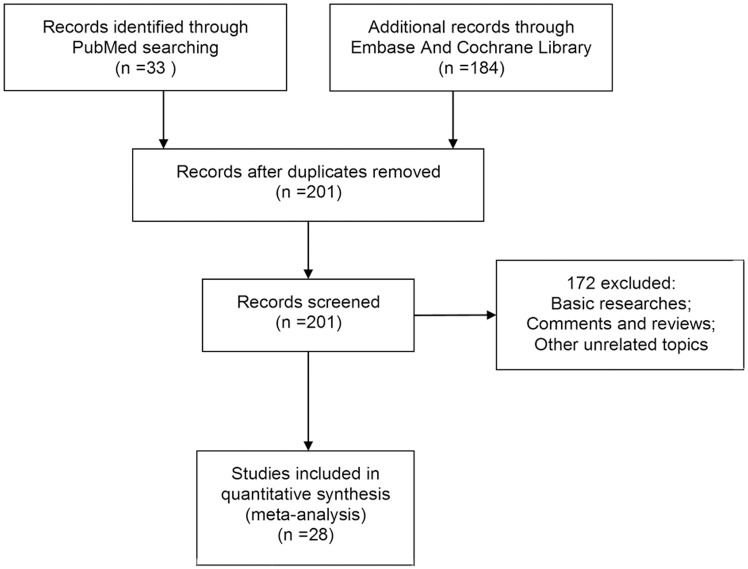
Flow diagram.PRISMA flow diagram.